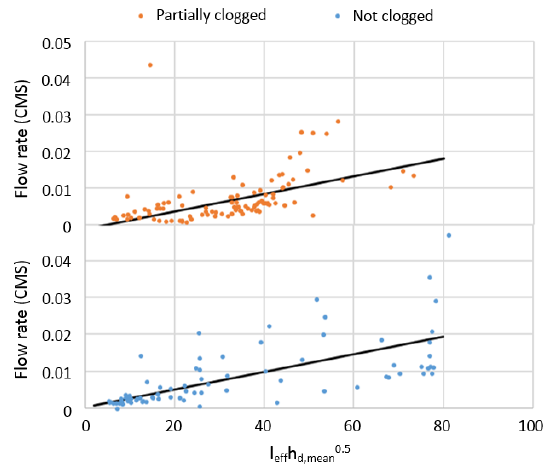
Figure 10. Performance plotted as flow rate vs. ℎ 𝑑,𝑚𝑒𝑎𝑛 𝑙 𝑒𝑓𝑓 for all data with 5-min rainfall depth >0.65 mm.